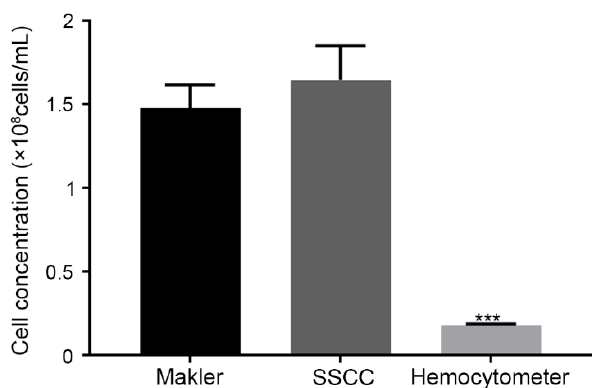
Figure 6. Performance comparison of a Makler ® counting chamber, SSCC device, and hemocytometer with zebrafish sperm ( n = 5, Mean ± SEM) with two-way ANOVA multiple comparisons (Dunnet). *** indicates P < 0.001 when compared to the Makler ® and SSCC.